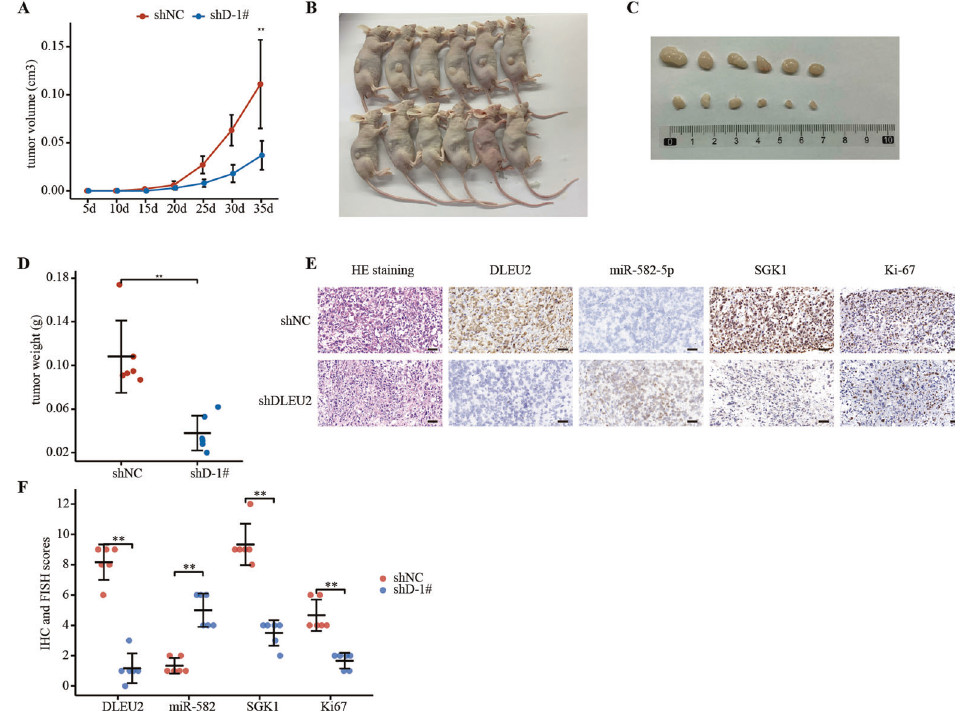
Fig. 7 Knockdown of DLEU2 suppressed prostate tumor growth in vivo. A The tumor growth curve of xenografts was plotted in shNC and shDLEU2 group ( n = 6 each group) by measuring the tumor size (0.5 × length × width 2 ) each 5 days. B The subcutaneous tumor models were observed at 35 days in two different groups. C Images of xenograft tumors of each group ( n = 6). D Weight of xenograft tumors of each group ( n = 6). E Representative HE staining, IHC staining of Ki-67, SGK1 and FISH of DLEU2, miR-582-5p in tumor xenografts were conducted (scale